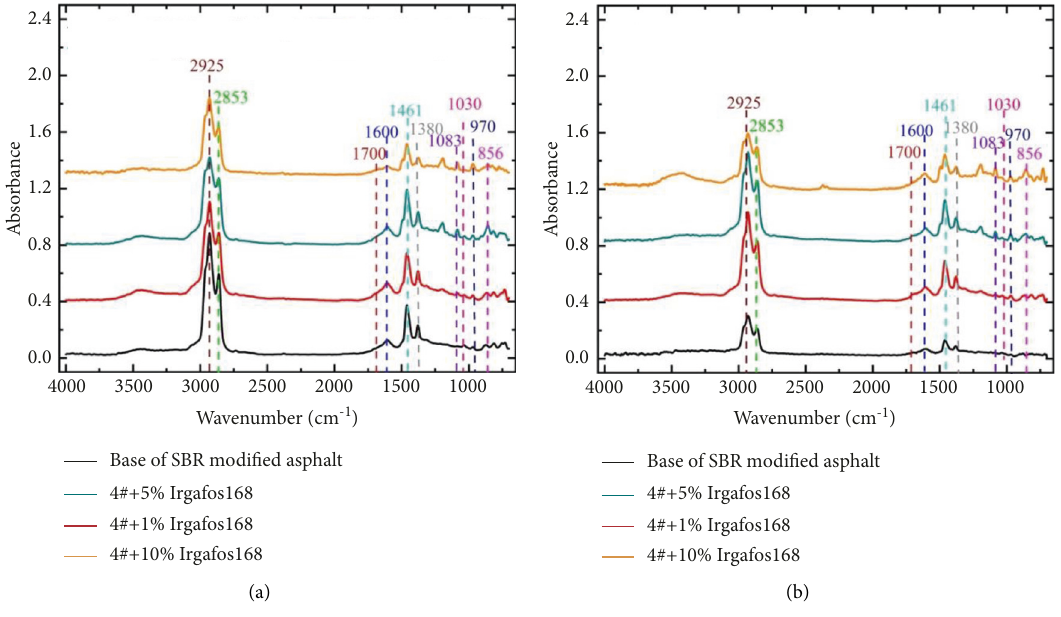
Figure 15: FTIR spectra of asphalt 4# (a) before aging (b) after